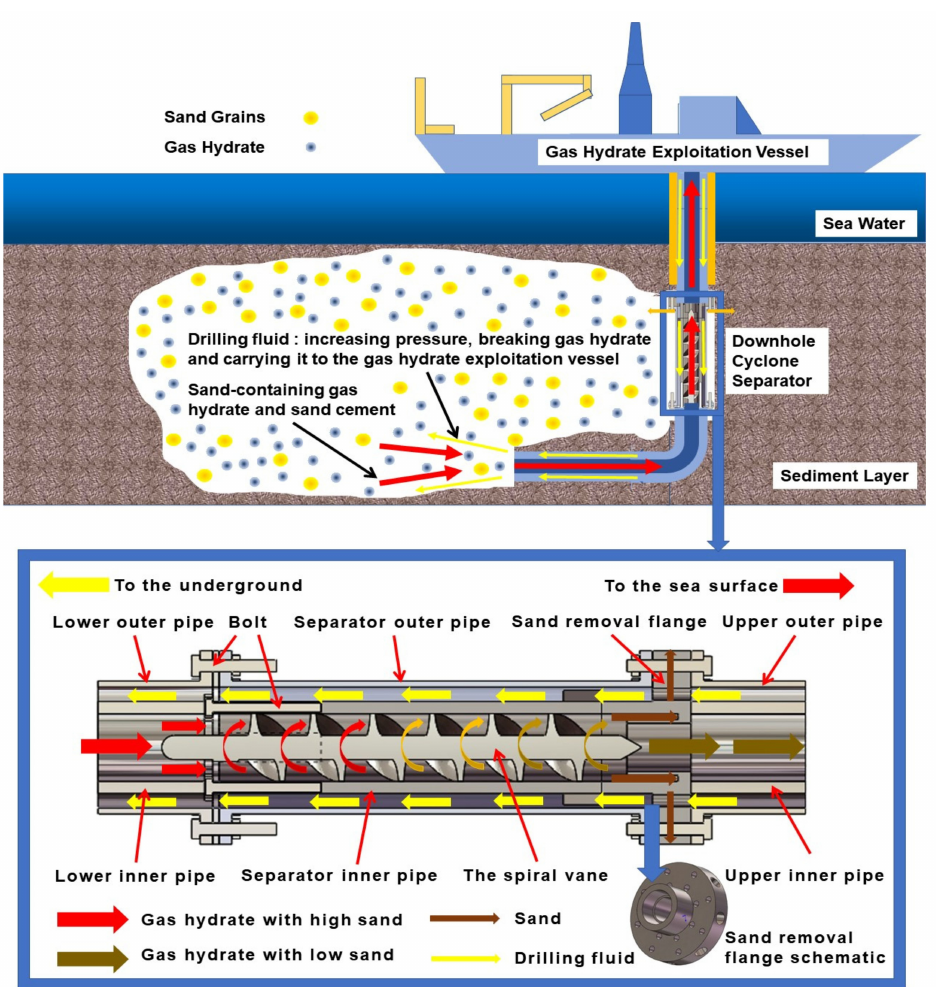
Figure 1. The technology of exploitation and separation of natural gas